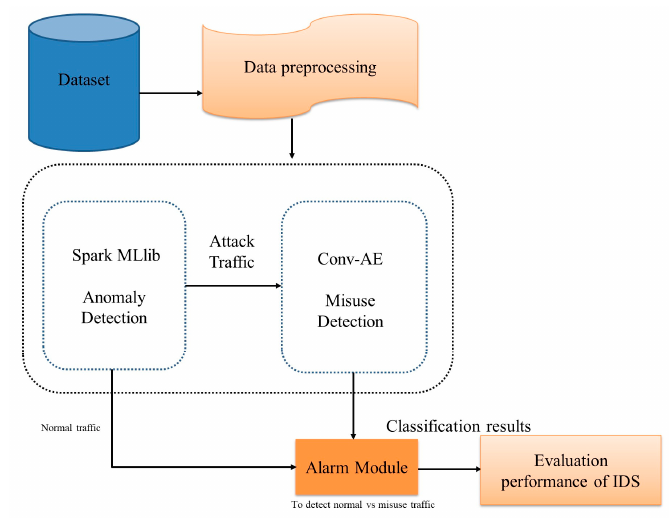
Figure 1. The overview of the proposed ID framework.